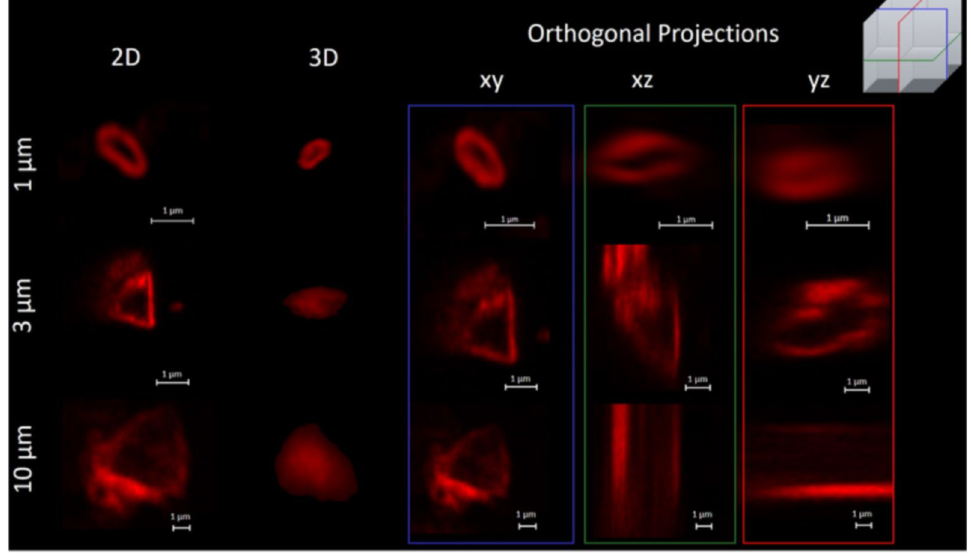
Figure 6. 2D view, 3D top view, and x–y, x–z, and y–z orthogonal projections of confocal section of individual rhodamine-tagged thiourethane functionalized filler particles incorporated in BUT organic matrix. The confocal images show an irregular shaped filler particle covered by an oligomeric layer (tagged in red), averaging 649 nm, 1226 nm and 1885 nm in thickness for the 1, 3 and 10 µm particles, respectively. The orthogonal projections show uneven thiourethane coating along the particle surface, with alternating regions showing a layer of up to 600 nm thickness, and other regions with no coverage (bare particle). Note: the orthogonal projections represent the cross-sections of particles, as indicated in the color-coded insert on the top right corner of the figure. To keep the size bars consistent across different projections, the 3 and 10 µm particles are not shown in their entirety in the xz and yz projections.